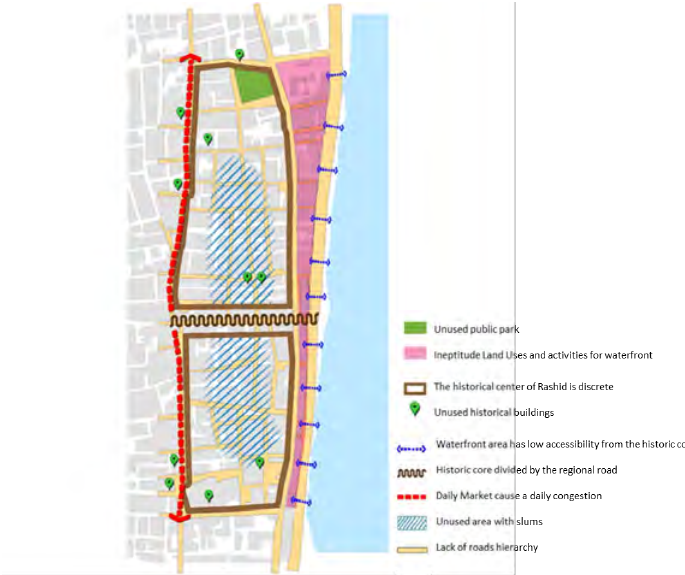
Figure 11. (Analysis of current Public realm of Rashid)